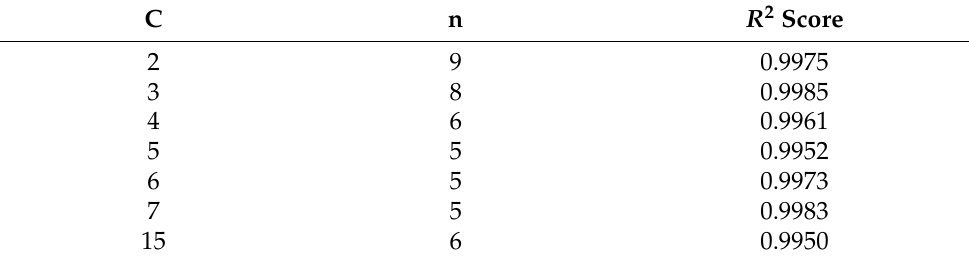
Figure 1. Polynomial Regression. Table 1. Optimal Order for Different